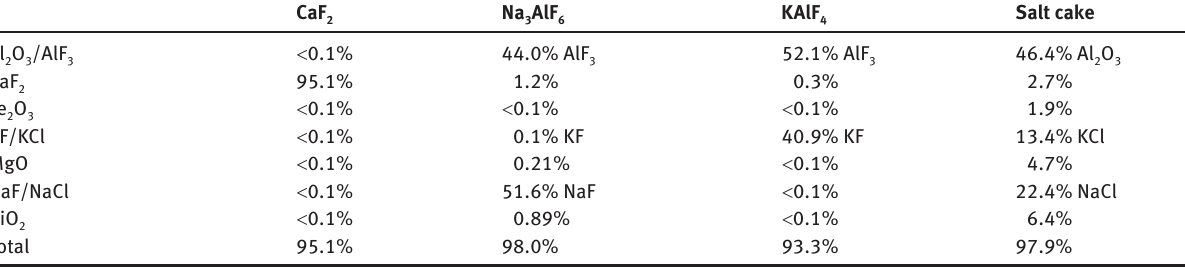
Table 2. Rheological testing with a rotational viscometer